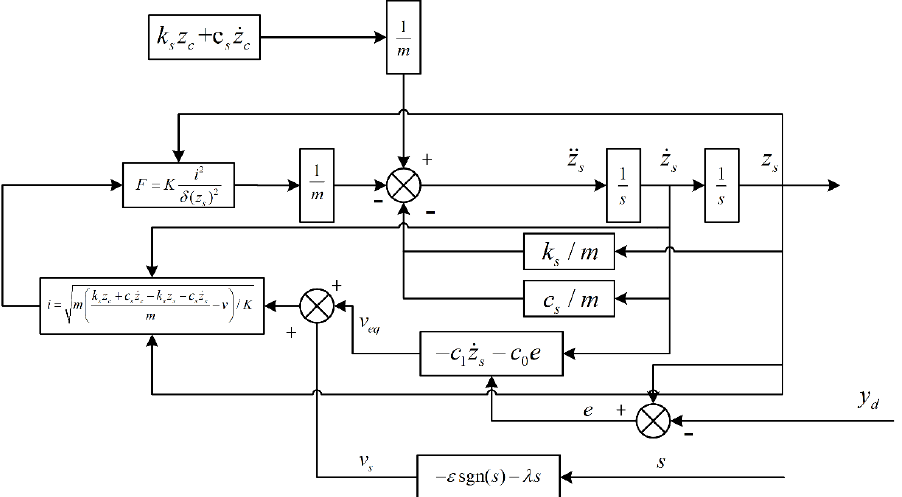
Figure 8. Structure block diagram of sliding mode control system.